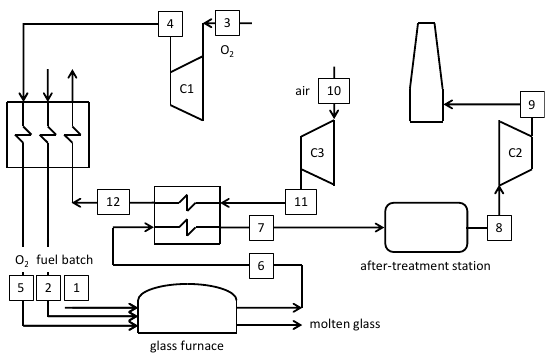
Figure 12. Schematic of the oxy-fuel furnace with heat recovery.